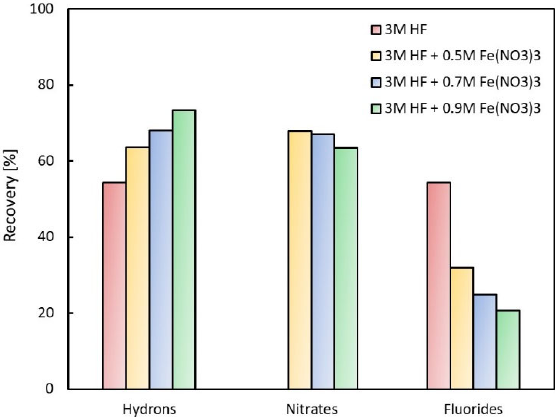
Figure 5. Comparison of recovery for different salt concentrations (150 mL h − 1